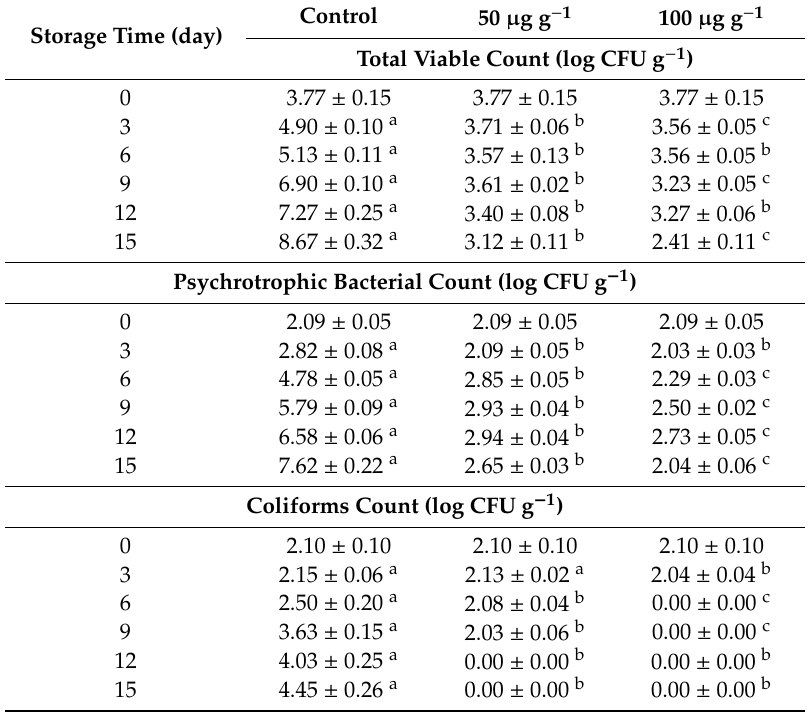
Table 1. Total viable count, psychrotrophic bacterial count and coliforms count (log CFU g − 1 ) in minced beef treated with catfish glycoprotein (CFG) at di ff erent concentrations (0, 50 and 100 µ g / g) and stored at 4 ◦ C throughout the storage period of 0–15 days.